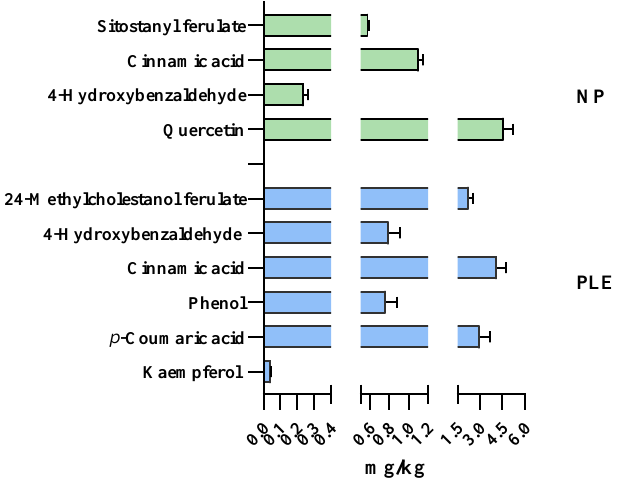
Figure 7. Concentration of phenolic components in PLE and non-pressurized extract.